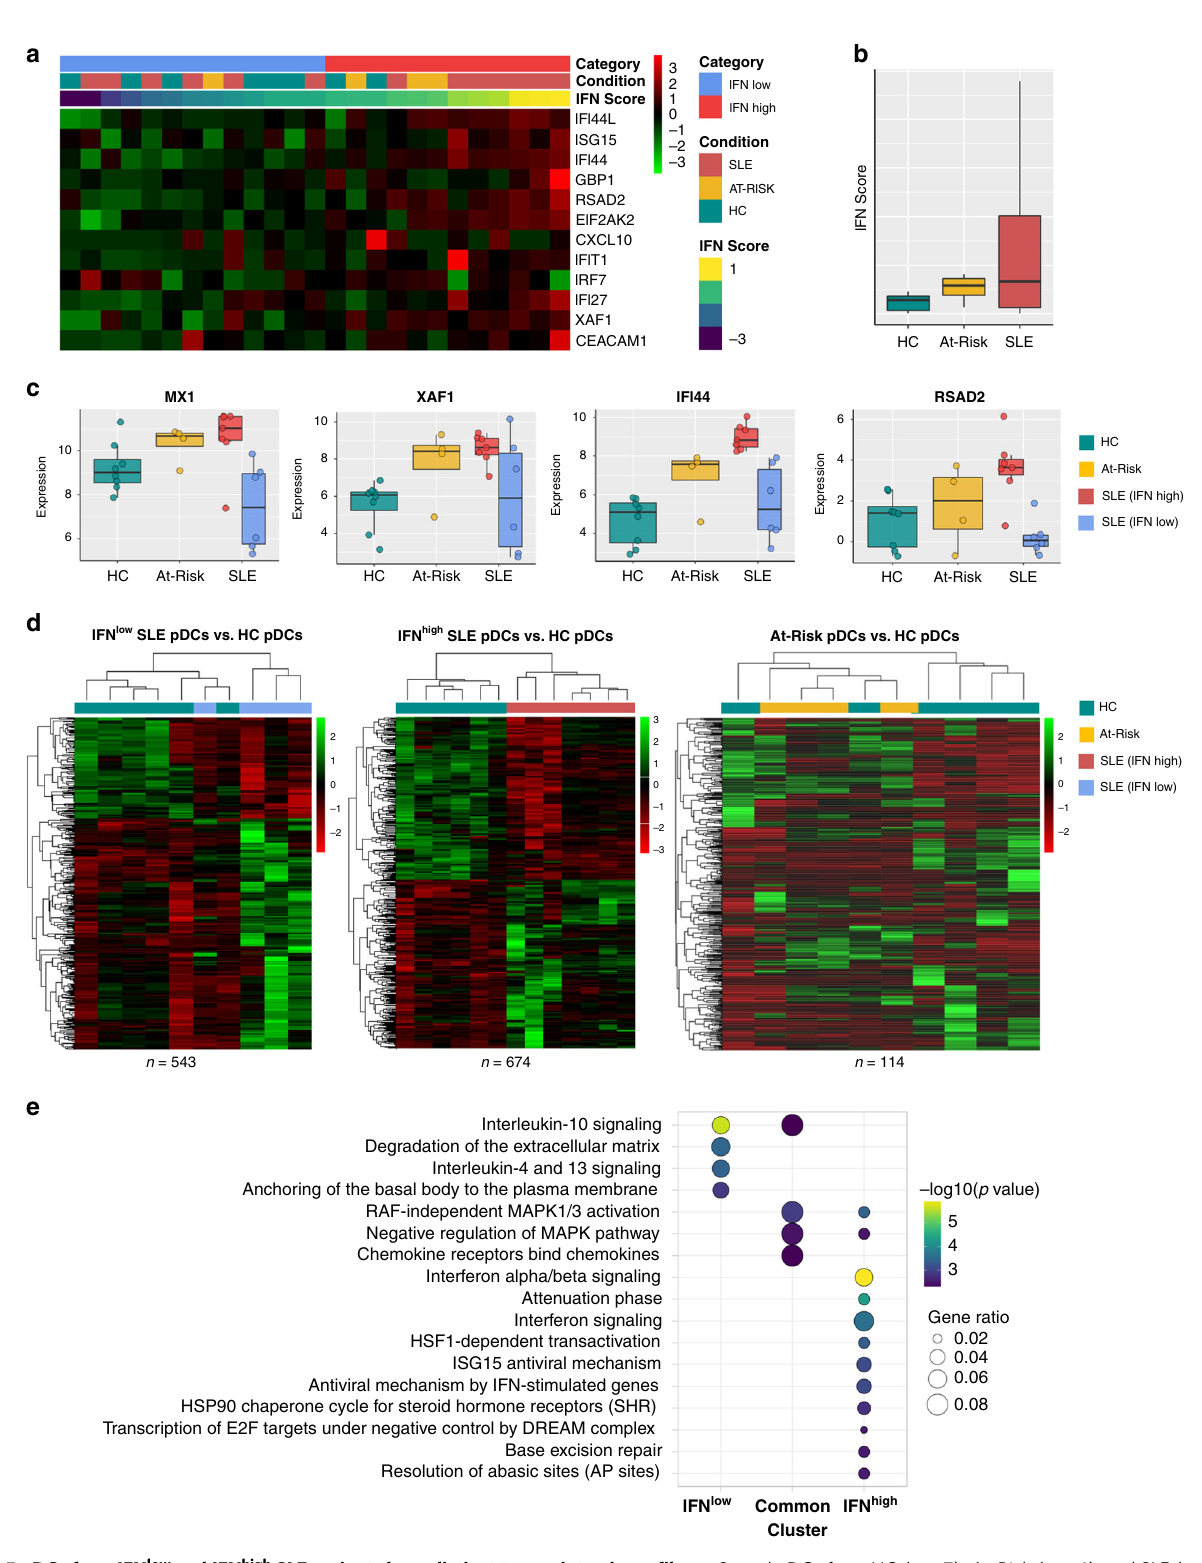
Fig. 5 pDCs from IFN low and IFN high SLE patients have distinct transcriptomic pro fi les. a Sorted pDCs from HC ( n = 7), At-Risk ( n = 4), and SLE ( n = 13) were classi fi ed according to the expression level of the IFN score described. b Average expression level of IFN score measured in samples described in a . c Expression level of representative ISGs in sorted pDCs from sample groups described in a . d Differentially expressed transcripts in IFN low SLE pDCs ( n = 543), IFN high SLE pDCs ( n = 674), and At-Risk pDCs ( n = 114) compared to HC pDCs. e Summary of the Reactome Pathway Enrichment in differentially expressed genes of the pDCs from IFN low and IFN high subgroups compared to HC